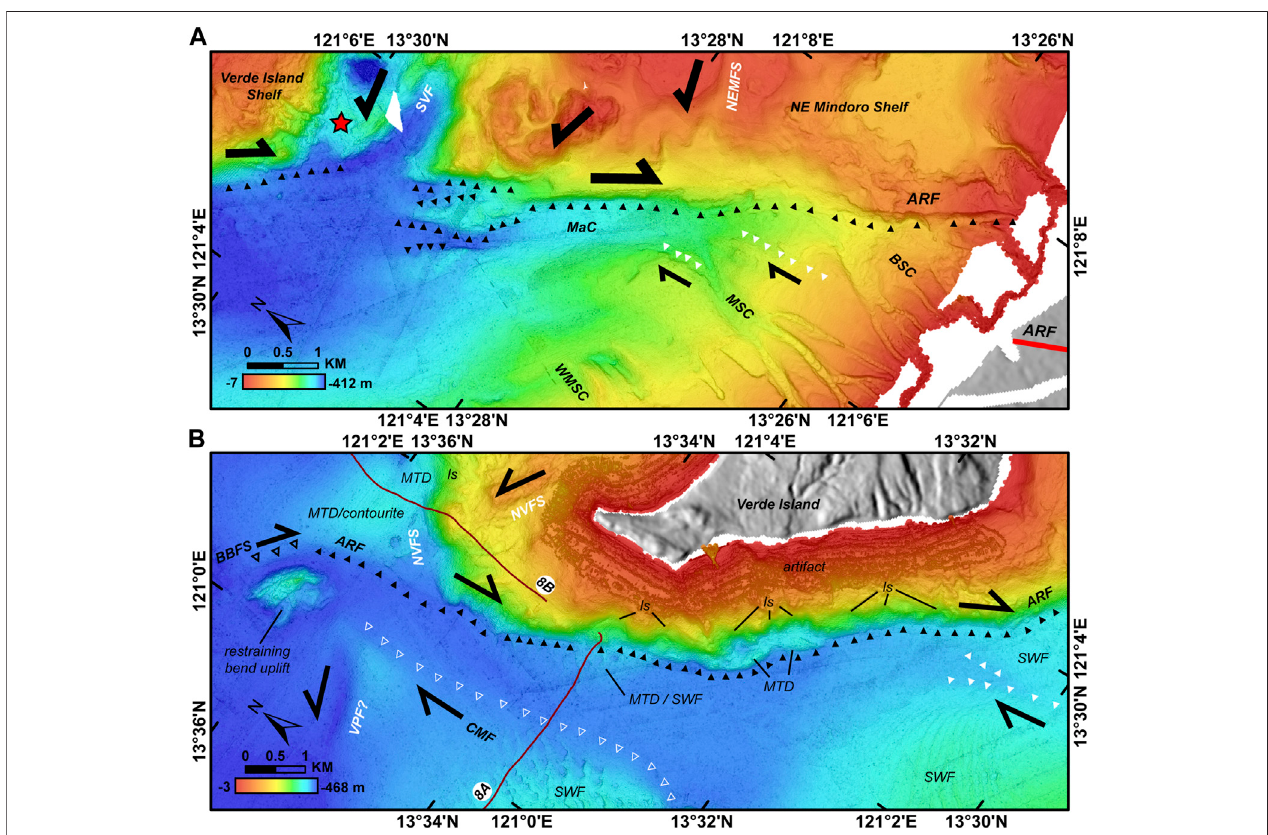
FIGURE 3 | Closeup of the southern (A) and northern (B) part of West Verde Basin. Filled black arrowheads indicate the trace of the Aglubang River Fault (ARF). Filled white arrowheads point to lineaments associated with ARF. Outlined black arrowheads represent Batangas Bay Fault System (BBFS) while outlined white arrowheadsshowthetraceoftheCentralMindoroFault(CMF).Blackhalfarrowsshowthedirectionoffaultmotion.Theothersurroundingfaultsareonlylabelledbutwith no arrowhead pointers. Other geomorphic features are also indicated such as landslide scarp (ls), mass transport deposit (MTD), and sediment wave fi eld (swf). Subbottom pro fi les are in maroon. The location of the 1994 earthquake is shown as a red star. Please refer to Figure 2 for the location of the fi gures. SVF, South Verde Fault;NEMFS,NortheastMindoroFault;VPF,VerdePassageFault.BSC,BacoSubmarineCanyon;MSC,MalalaySubmarineCanyon;WMSC,WestMalalaySubmarine Canyon; MaC, Main